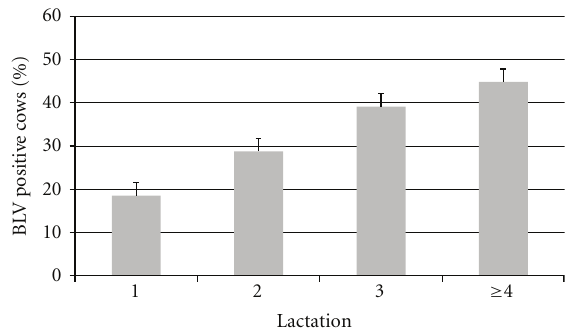
Figure 2: Mean prevalence, by lactation, of cows from 113 dairy herds that were positive for Bovine Leukemia Virus (BLV) by milk ELISA. For the null hypothesis that the true population correlation coe ffi cient is zero, analysis of variance was significant ( P < 0 . 0001).